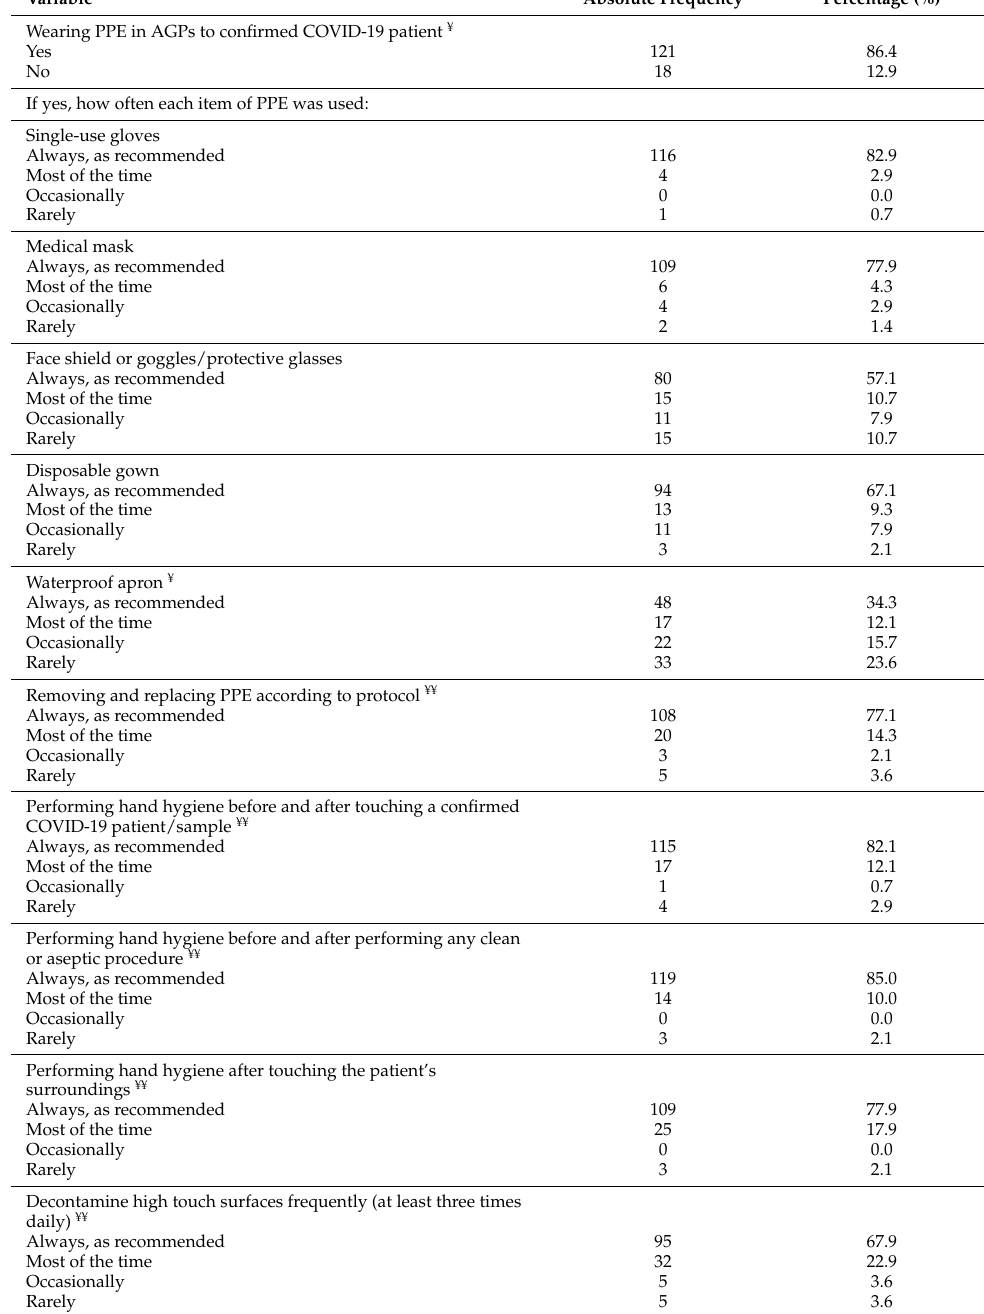
Table 4. Adherence to IPC procedures when performing